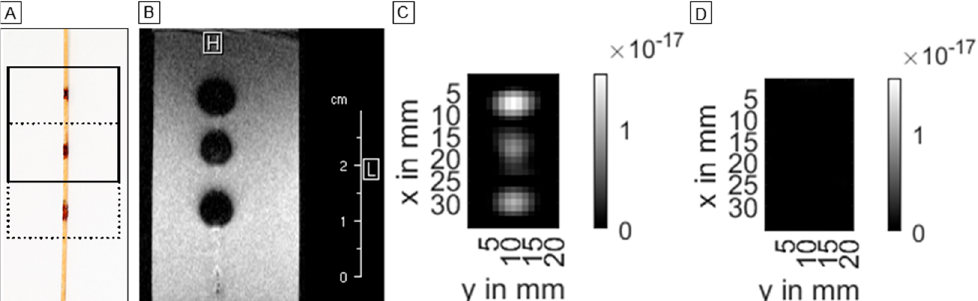
Figure 4. Overview of the marked guidewire ( A ) and the image results in MRI ( B ) and MPI ( C , D ). In ( A ), the two positions of the MPI FOV are shown. In MRI, the markers cause circular signal voids ( B ). For MPI, two images are shown: ( C ) shows an image based on the KLB channel of the combined system matrix and ( D ) is the reconstruction result of the Bayoxide E8706 channel (both images showing the central z-slice, i.e., slice 7).